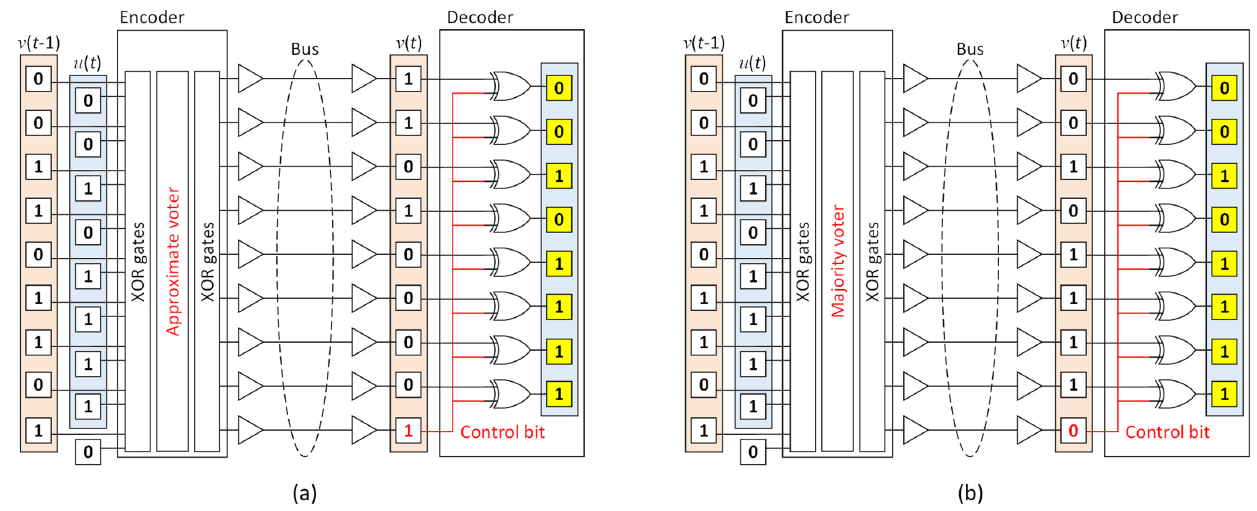
Figure 6. Bus decoding with ( a ) approximate voter and ( b ) majority voter.